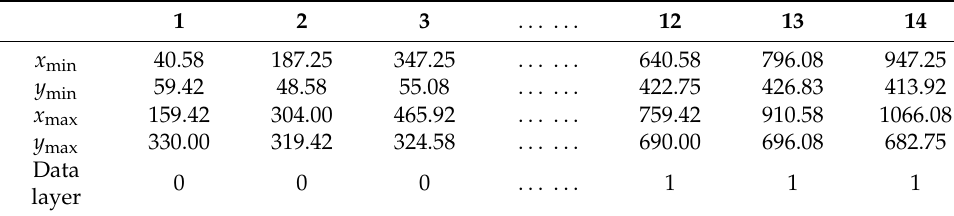
Table 4. Position of each vehicle after sorting using the data layering method.